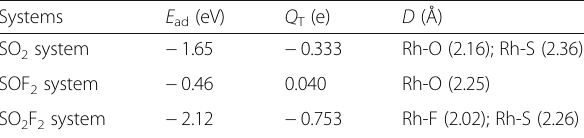
Table 1 Adsorption parameters of Rh-MoTe 2 monolayer upon SO 2 , SOF 2 , and SO 2 F